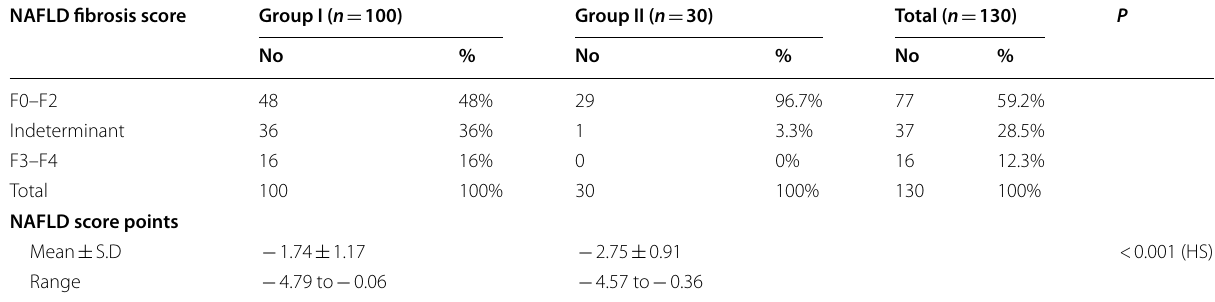
Table 3 NAFLD fibrosis score among the studied groups